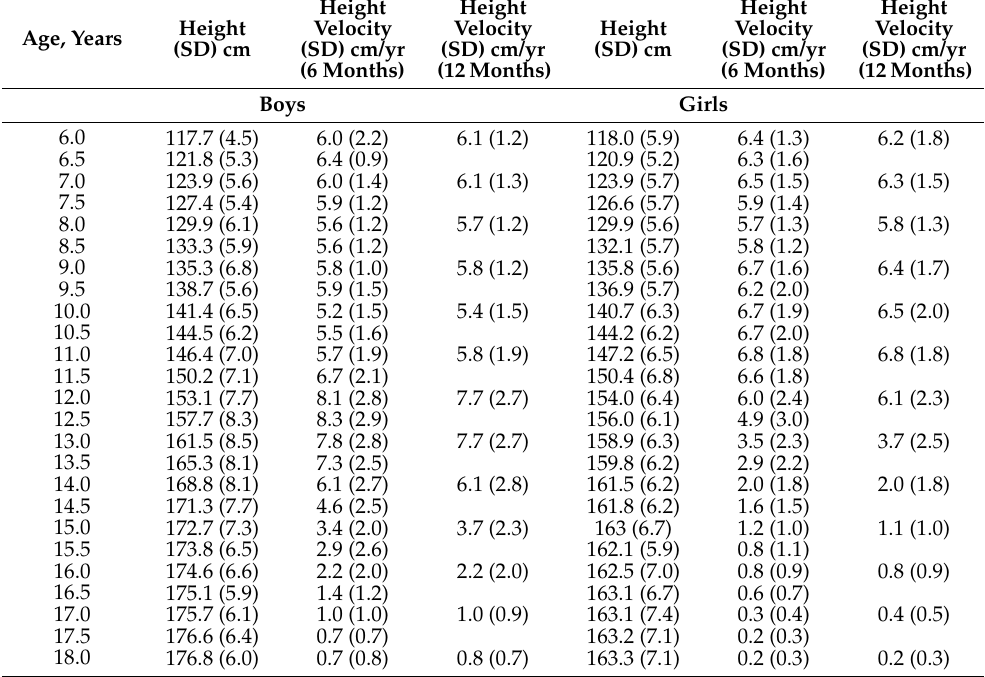
Table 2. Mean height (SD) and height velocity (SD) of schoolchildren 6–18 years by 6 and 12-month- age